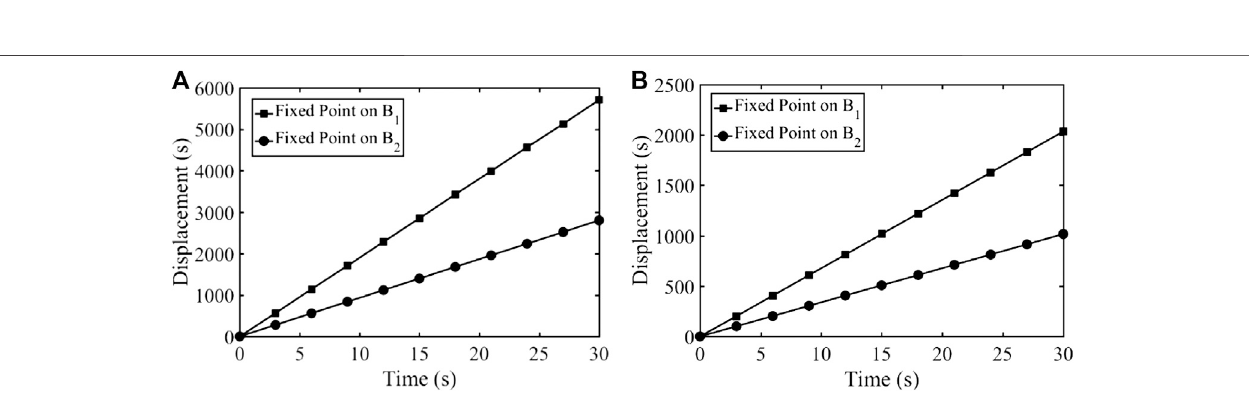
FIGURE 15 | Horizontal (A) and vertical displacement (B) when the fi xed point on B1 and